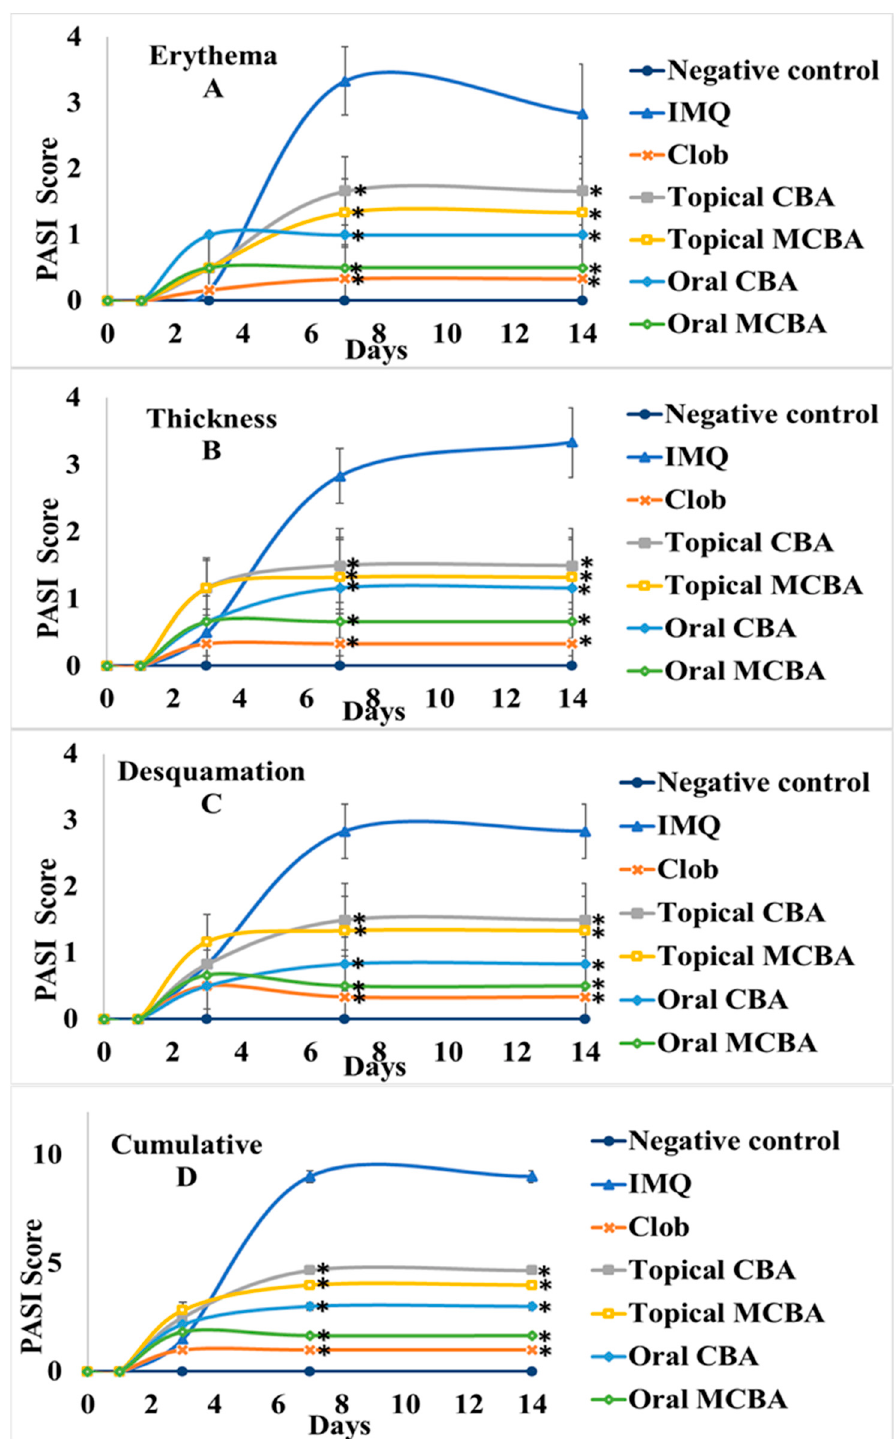
Figure 2. Psoriasis area and severity index (PASI) scores of different groups on days 1, 3, 7, and 14. ( A ) Erythema score, ( B ) thickness score, ( C ) desquamation score and, ( D ) cumulative score. (*) Indicates significant difference ( p < 0.05) from IMQ-treated group ( n = 6).